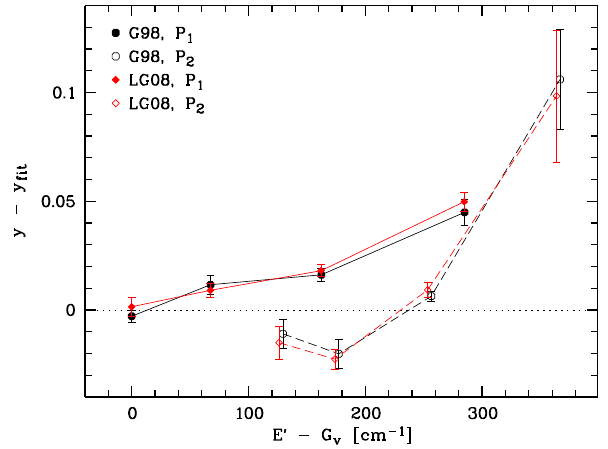
Figure 4. Over- and underpopulation of the upper rotational levels of the P -branch OH lines relative to a regression line based on the first three P 1 and P 2 lines. The abscissa shows the energy differ- ence in cm − 1 of an upper rotational level E (cid:48) to the lowest level G v . The ordinate exhibits the natural logarithm of a population ratio. The data points show the mean values and mean errors of the four investigated P 1 (filled symbols and solid lines) and P 2 lines (open symbols and dashed lines) for the OH bands (4-1), (5-2), (6-2), and (7-4). The results for the G98 and LG08 line parameters are marked by circles and diamonds,